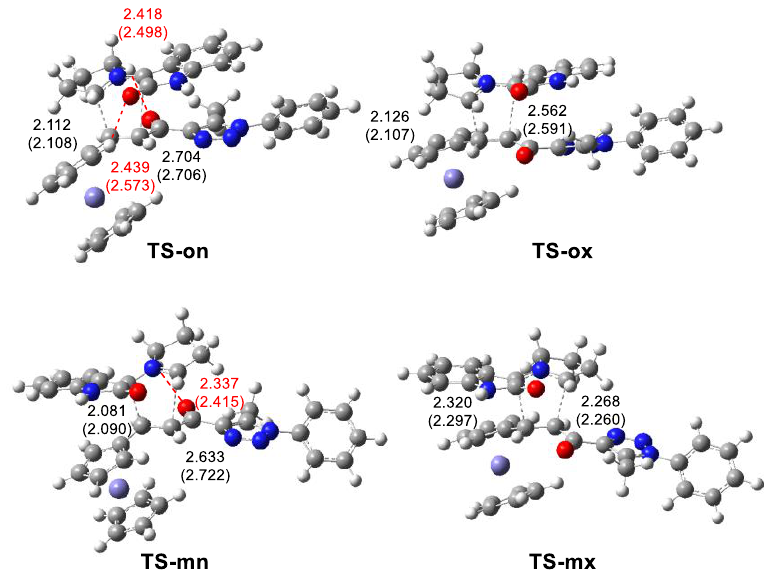
Figure 5. ω B97X-D/6-311G(d,p) optimized geometries of the TSs associated with the 32CA reaction of AY 21 with ferrocene ethylene 22 . Distances are given in angstroms, Å . Distances in methanol are given in parentheses. HB distances are given in red.